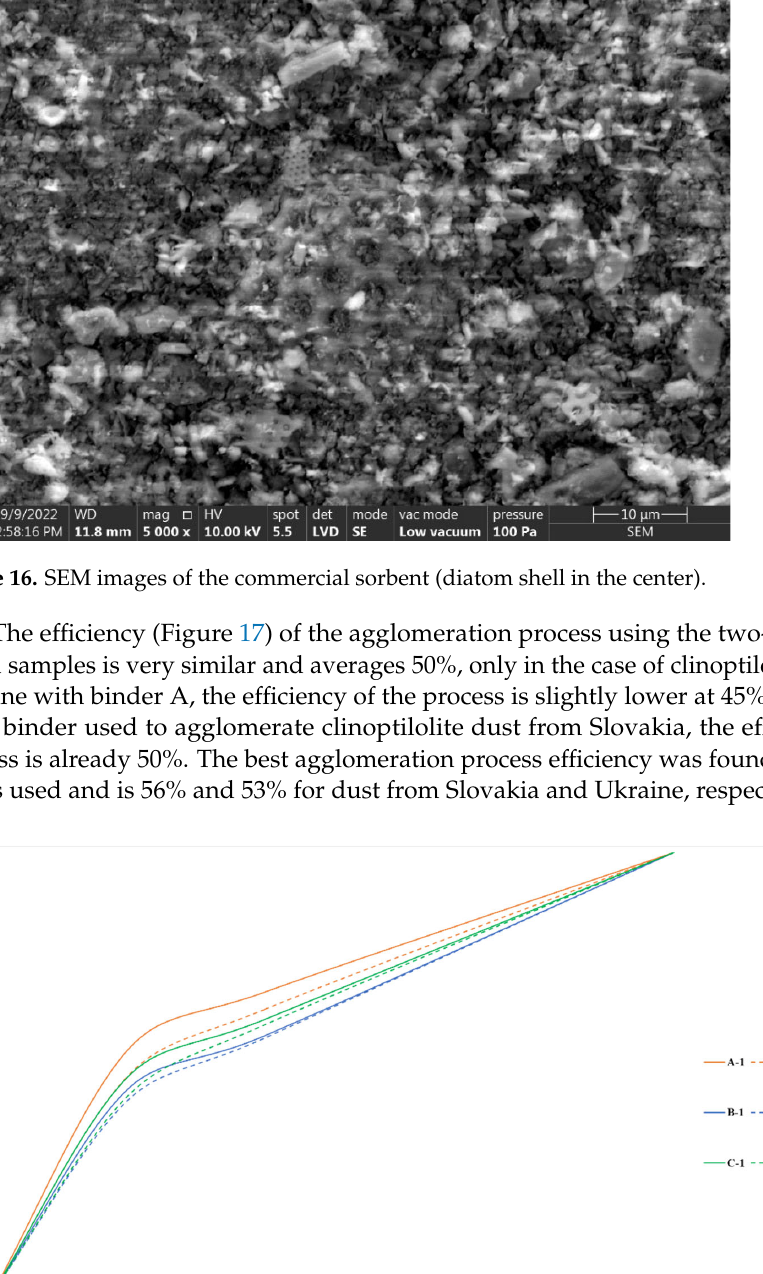
Figure 15. SEM images of the C ‐ 2 agglomerate surface.